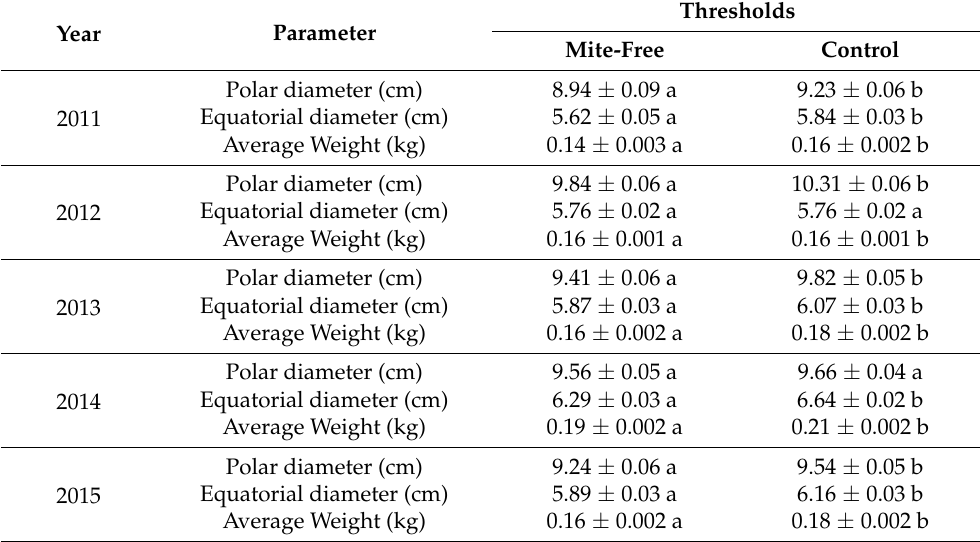
Table 8. Mean ( ± SE) average weight (kg), polar and equatorial diameter (cm) for avocado trees subjected to two treatments over a period of five years in M á laga. SE followed by letters compares differences between treatments for each variable and year, and when the letters are different, the difference is significant according to Tukey’s HSD multiple range test: p < 0.05.